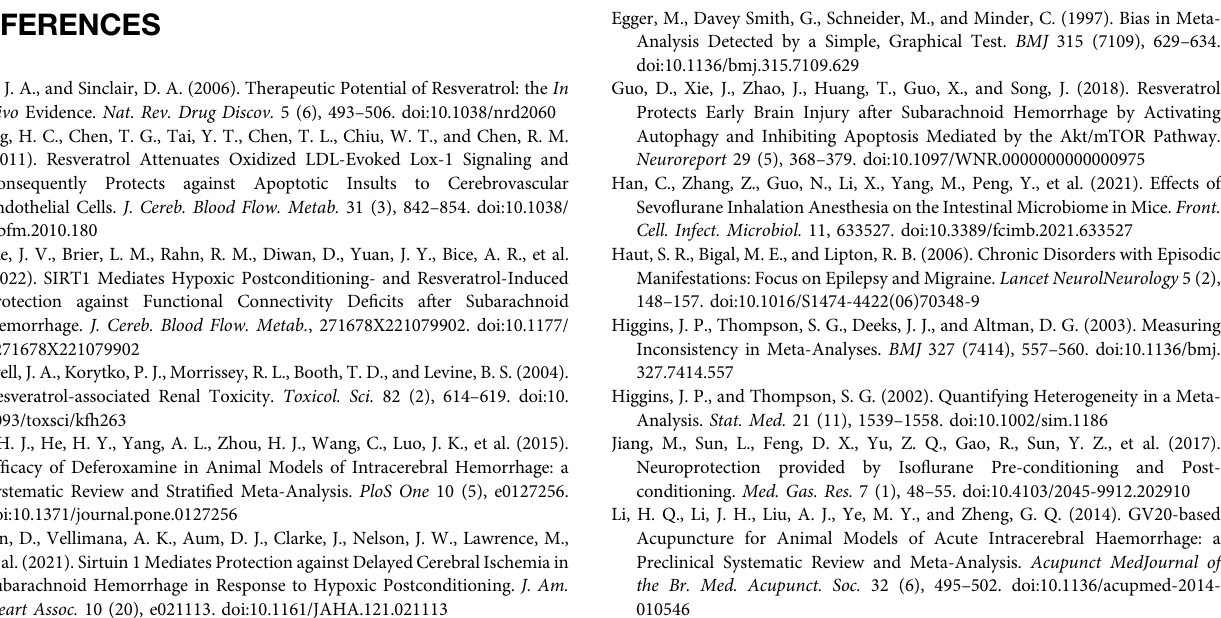
Supplementary Figure S1 | Strati fi ed analysis by study quality. Supplementary Figure S2 | Strati fi ed analysis by anesthetic drug. Supplementary Figure S3 | Strati fi ed analysis by method to induce SAH. Supplementary Figure S4 | Strati fi ed analysis by total dosage of RES. Supplementary Figure S5 | Strati fi ed analysis by dose administration of RES. Supplementary Figure S6 | Strati fi ed analysis by time administration of RES. Supplementary Figure S7 | Strati fi ed analysis by time point of outcome